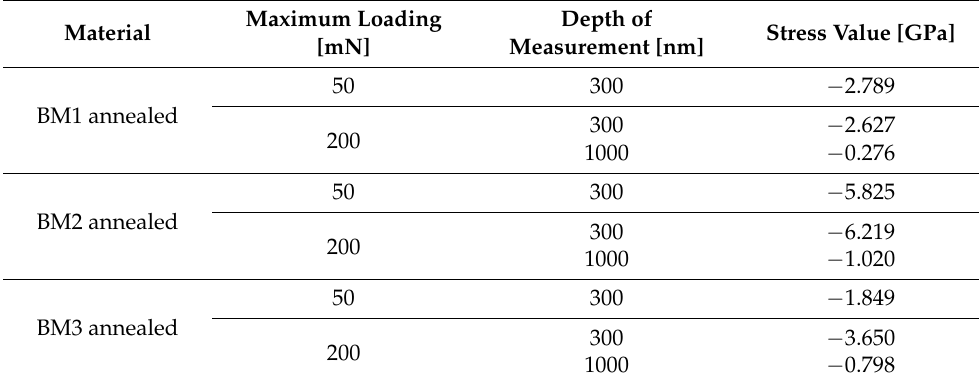
Table 12. List of calculated values of residual stresses of annealed